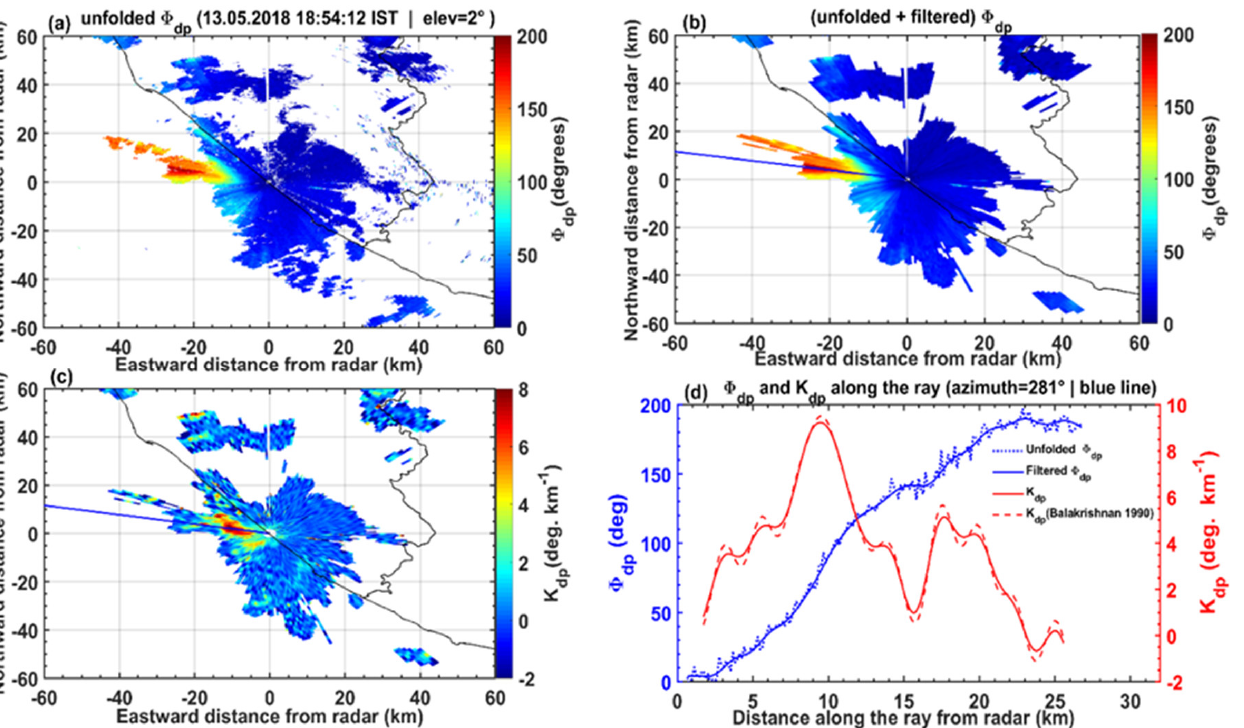
Figure 3. PPI diagrams at 2 ◦ elevation of ( a ) unfolded Φ dp , ( b ) filtered Φ dp and ( c ) estimated K dp . Blue line in ( b , c ) represents 281 ◦ azimuth. ( d ) Variation of Φ dp (blue) and K dp (red) along 281 ◦ azimuth at 18:54:12 IST, 13 May 2018.